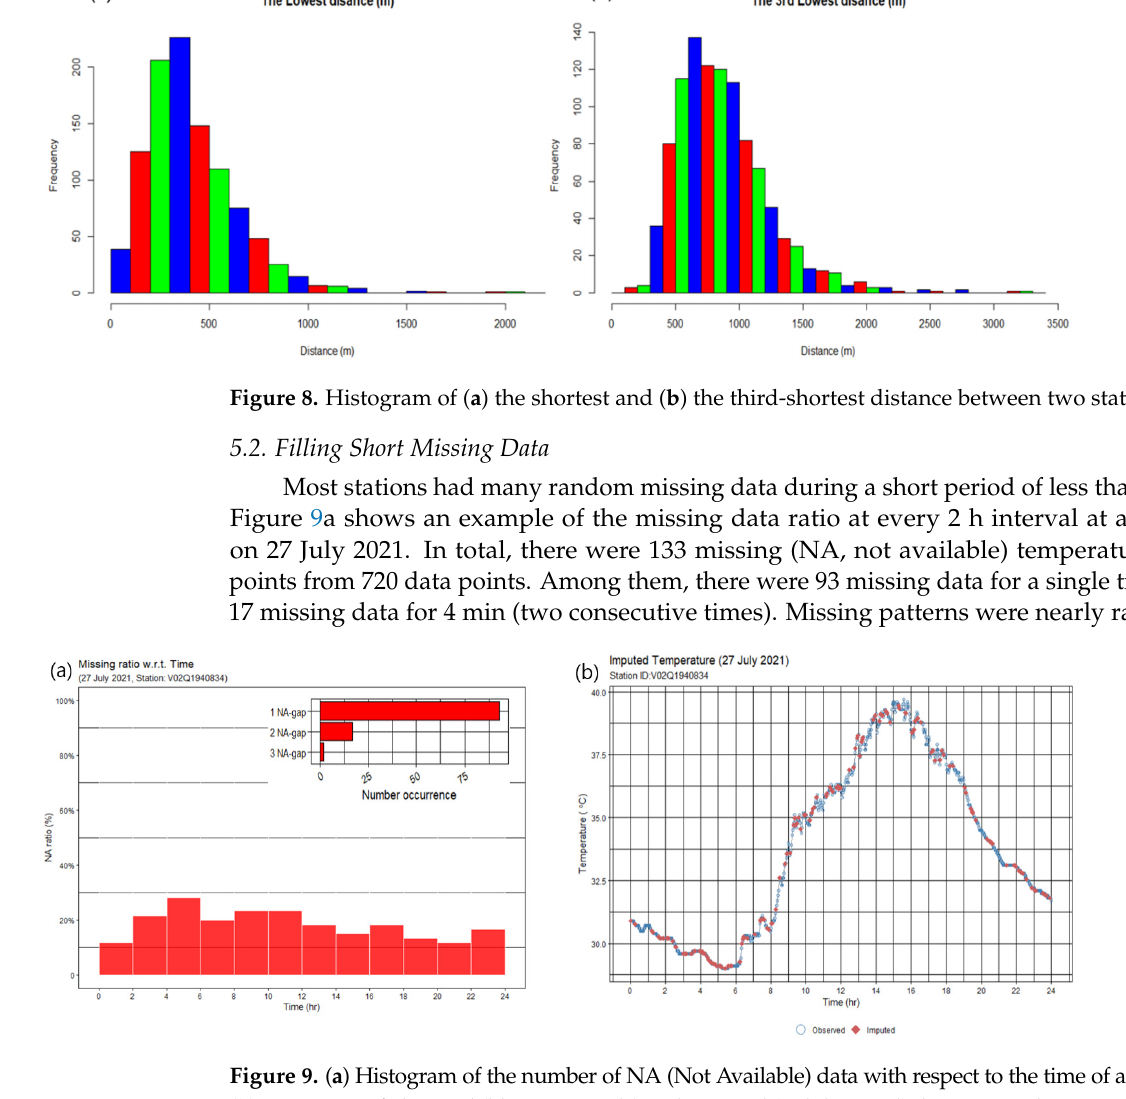
Figure 10. Ratio of missing data with respect to ( a ) day of the year and ( b ) station alphabetical order. 5.3. Basic Quality Control Figure 11 shows an example of errors found using persistence and step checks. None of the data including temperature, relative humidity, PM 2.5 , and PM 10 changed with time (Figure 11a). Contrastingly, all data were 0 at a given time (Figure 11b). Temporal differ- ences in temperature (25 °C) and relative humidity (98%) were above the threshold values of 3 °C and 10%, respectively.